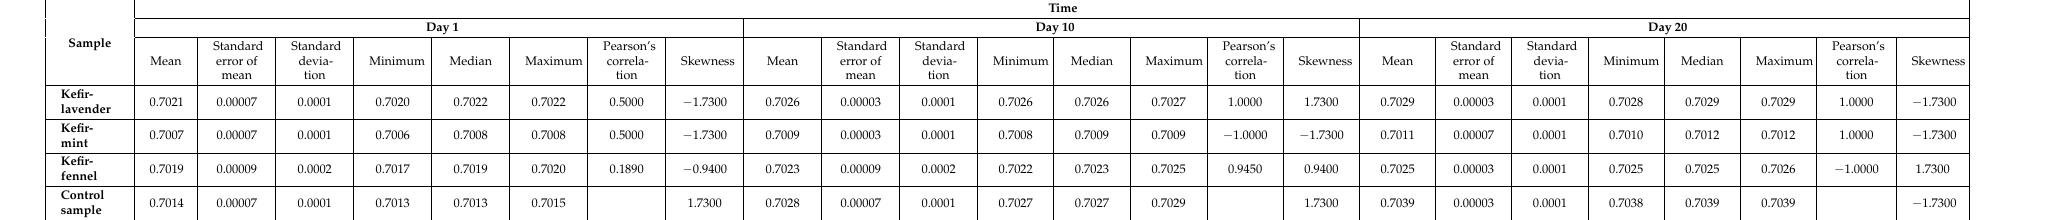
Table A7. Determination of L-lactic acid